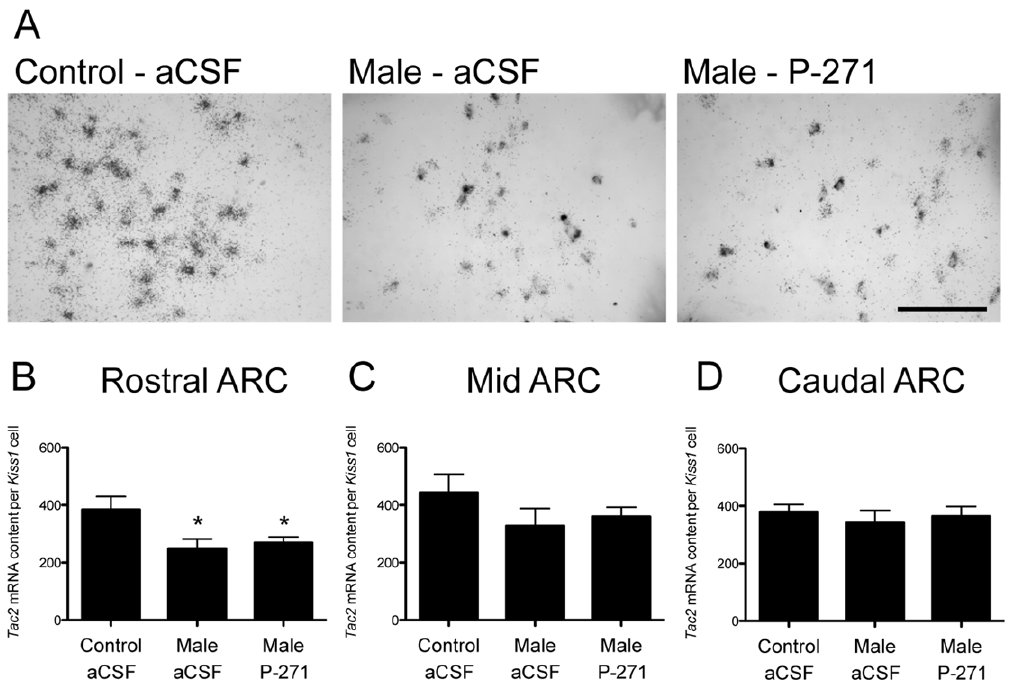
Figure 7. Male exposure in ewes decreased the content of Tac2 mRNA in the rostral ARC. A, Representative bright-field photomicrographs showing neurons in the rostral ARC containing Kiss1 mRNA (grey) and Tac2 mRNA (as indicated by the presence of silver grain clusters). 3V, Third ventricle. Scale bar , 50 m m. B–C, Tac2 mRNA content per Kiss1 cell was significantly reduced in anestrous ewes exposed to males compared to non- exposed controls in the rostral ARC (B). P-271 had no effect on Tac2 mRNA content. Data are the mean 6 SEM, *P , 0.05, n=4 per